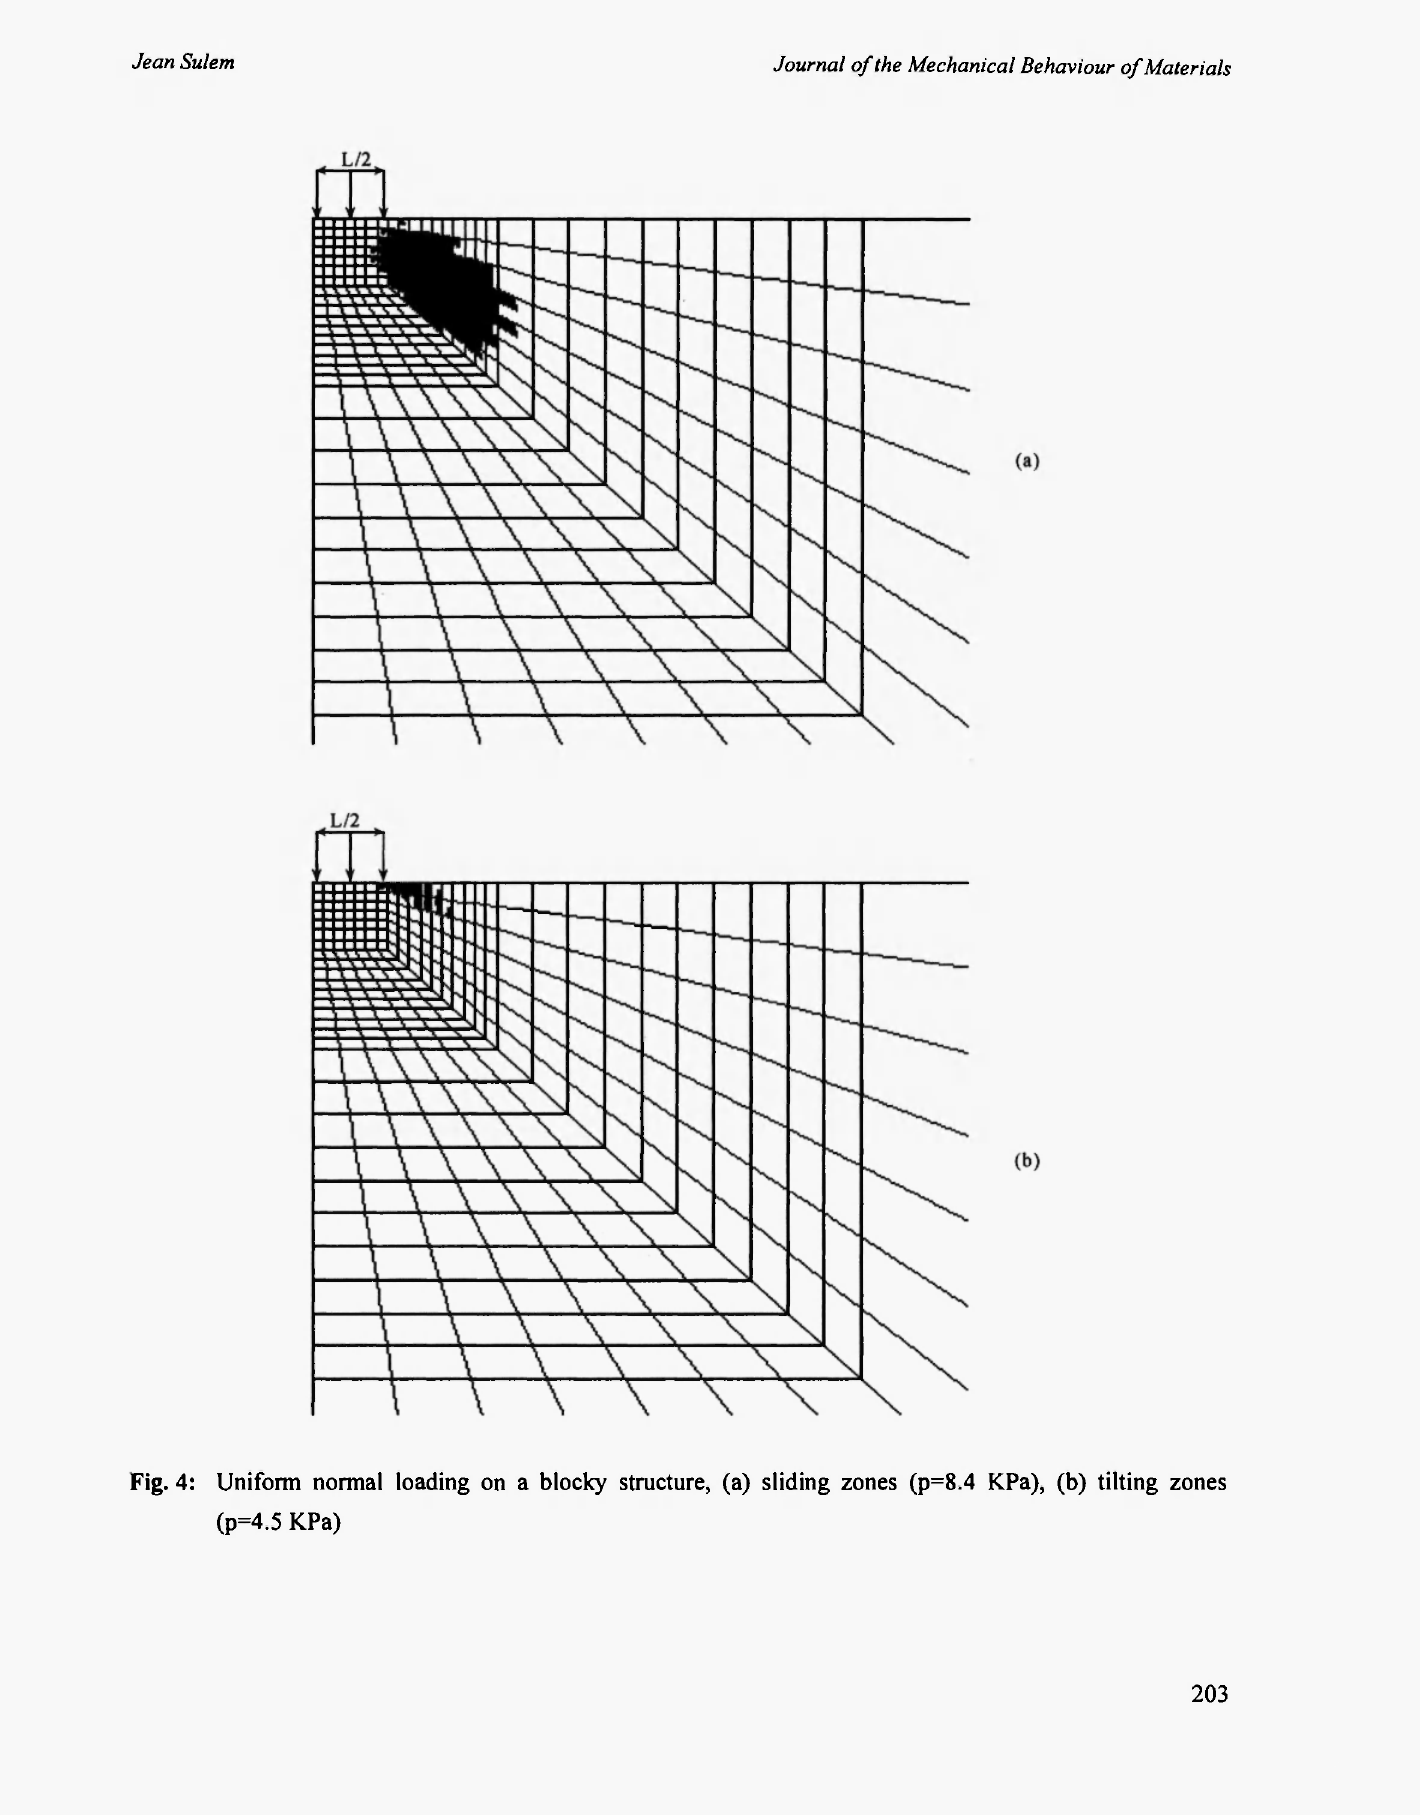
Fig. 4: Uniform normal loading on a blocky structure, (a) sliding zones (p=8.4 KPa), (b) tilting zones (p=4.5 KPa)